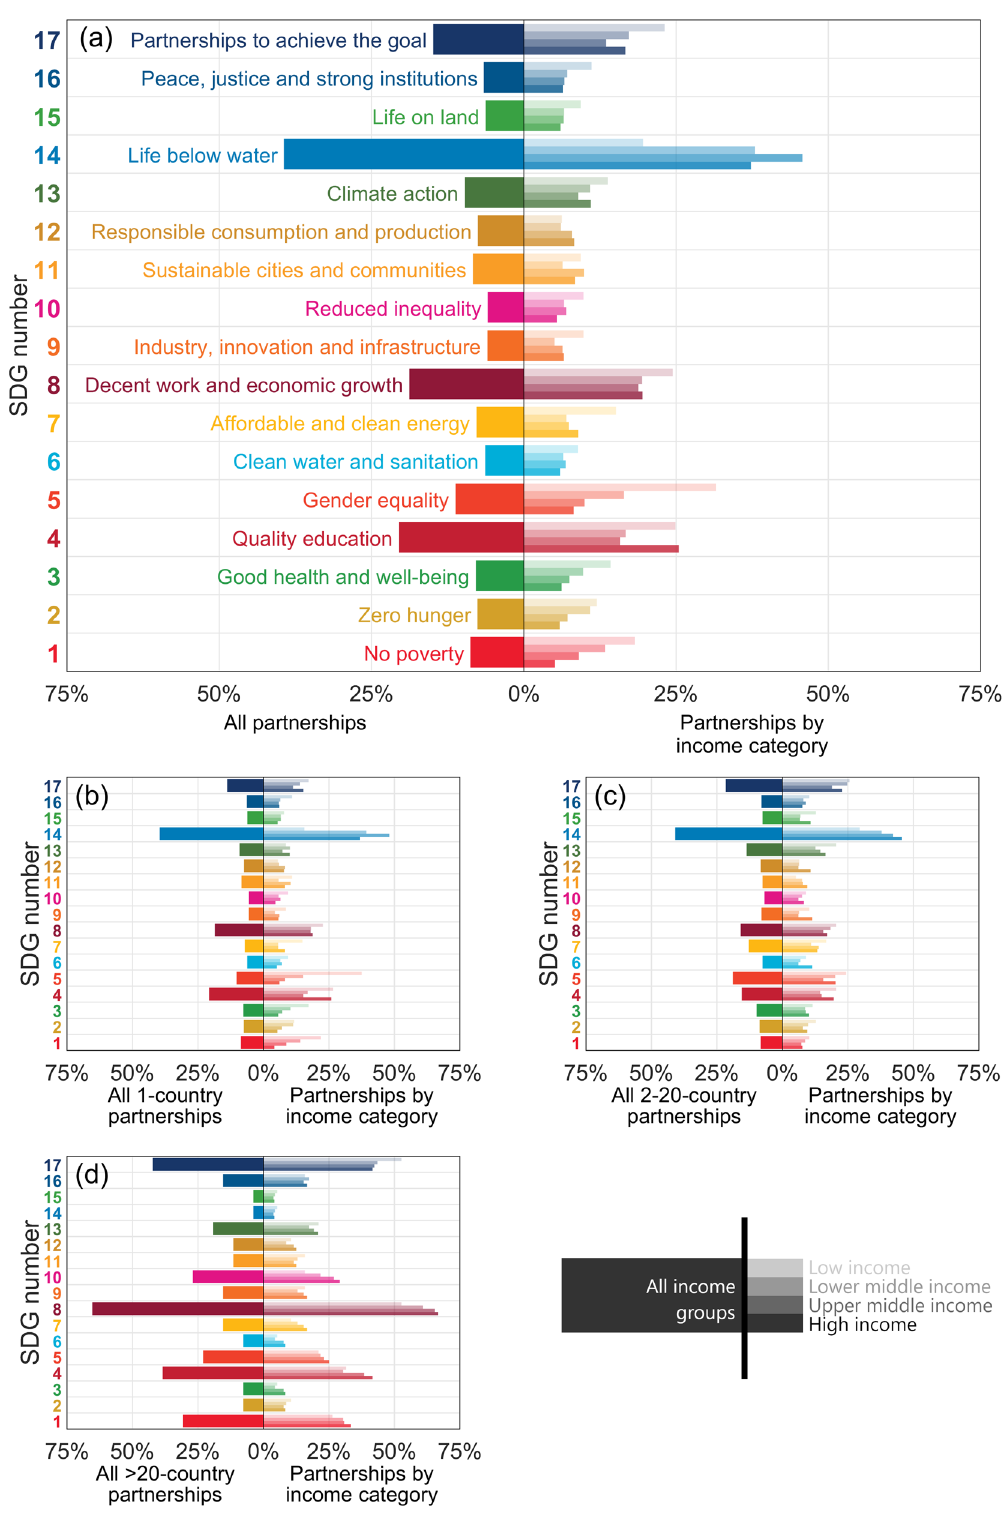
Figure 4. Partnerships’ focal SDGs. The SDGs addressed by ( a ) all partnerships that specifically identified partners from at least one country, ( b ) domestic partnerships, ( c ) partnerships involving 2 to 20 countries, and ( d ) partnerships with more than 20 countries. The bars on the left of Figs. 4a to 4d represent the percentage of partnerships that address each SDG. The bars on the right of Figs. 4a to 4d represent the percentage of partnerships that address each SDG involving partners from countries in each income category (represented by different intensities of colour). Note that many partnerships include partners from countries across multiple income categories and address more than one SDG. Larger versions of the components of this figure are included in Supplementary